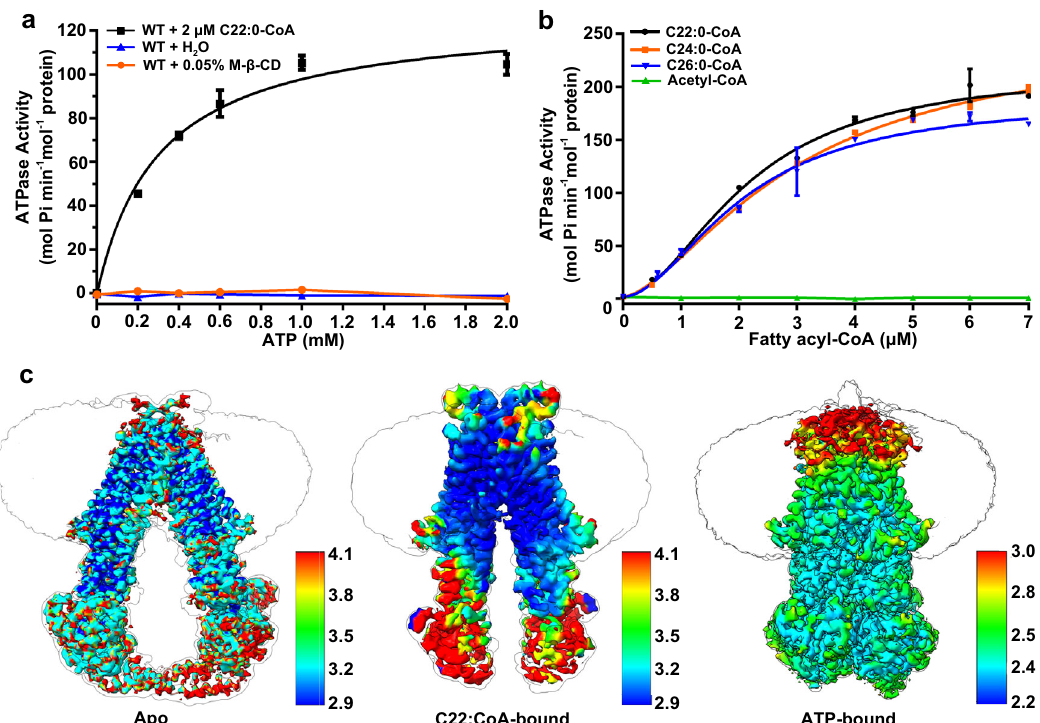
Fig. 1 Substrate-stimulated ATPase activity assays and structure determination of ABCD1. a ATPase activity of chABCD1 in the presence or absence of C22:0-CoA in detergent of LMNG + CHS. 0.05% methyl- β -cyclodextrin (M- β -CD) which functions as the solvent of substrate, was also tested as the control group. The data points were fi tted with a Michaelis-Menten equation. b Substrate concentration-dependent ATPase activity of chABCD1 in detergent of LMNG + CHS and 2 mM ATP upon addition of varying fatty acyl-CoA. The data points were fi tted with a Hill equation. All data points for a and b represent means of three independent measurements ( n = 3) in detergent of LMNG and CHS. Error bars indicate standard deviation. Source data are provided as a Source Data fi le. c Re fi ned cryo-EM map of three ABCD1 structures. The unsharpened maps are displayed as the outline to show the position of the detergent micelle. The cryo-EM map are colored by UCSF ChimeraX 1.2.5 according to the local resolution of the cryo-EM estimated by RELION 3.1 or cryoSPARC